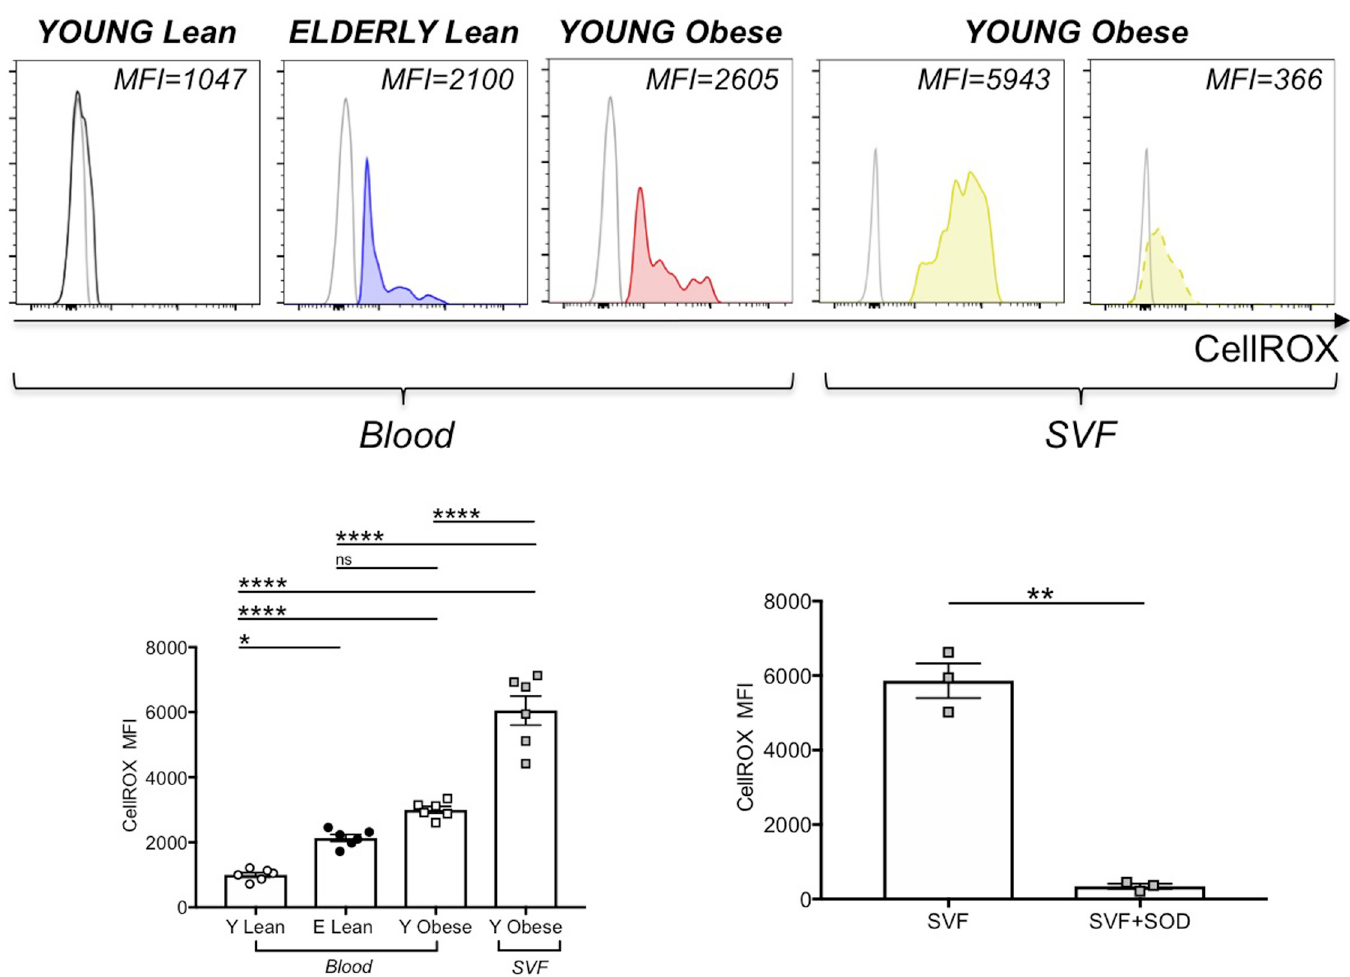
Fig 9. Effects of aging and obesity on ROS in DN B cells. PBMC and SVF were obtained as indicated previously. Top . Representative histograms of CellROX are shown for each group of individuals (solid lines). The dotted line in the last histogram indicates CellROX staining in SVF samples pre-incubated with Vitamin E (100 μ g/10 6 SVF). Bottom, left . Mean Fluorescence Intensity (MFI) ± SE of CellROX. In each histogram, unstained cells are used as negative controls. Mean comparisons between groups were performed by one-way ANOVA. � p < 0.05, ���� p < 0.0001, ns: not significant. Bottom, right . The SVFs from 3 young obese individuals (among those in the left graph) were pre-incubated for 30 min with Vitamin E before adding CellROX. Results show MFI ± SE of CellROX. Mean comparisons between groups were performed by Student’s t test (two-tailed). �� p < 0.01.